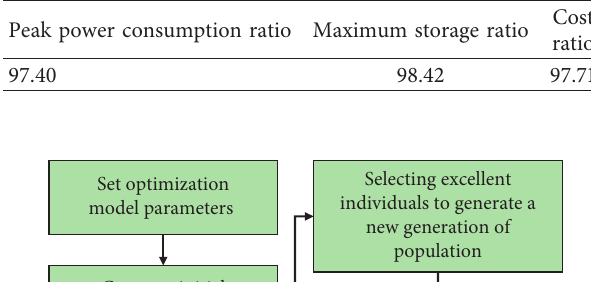
Table 5: Ratio of the statistic of users and their combination.